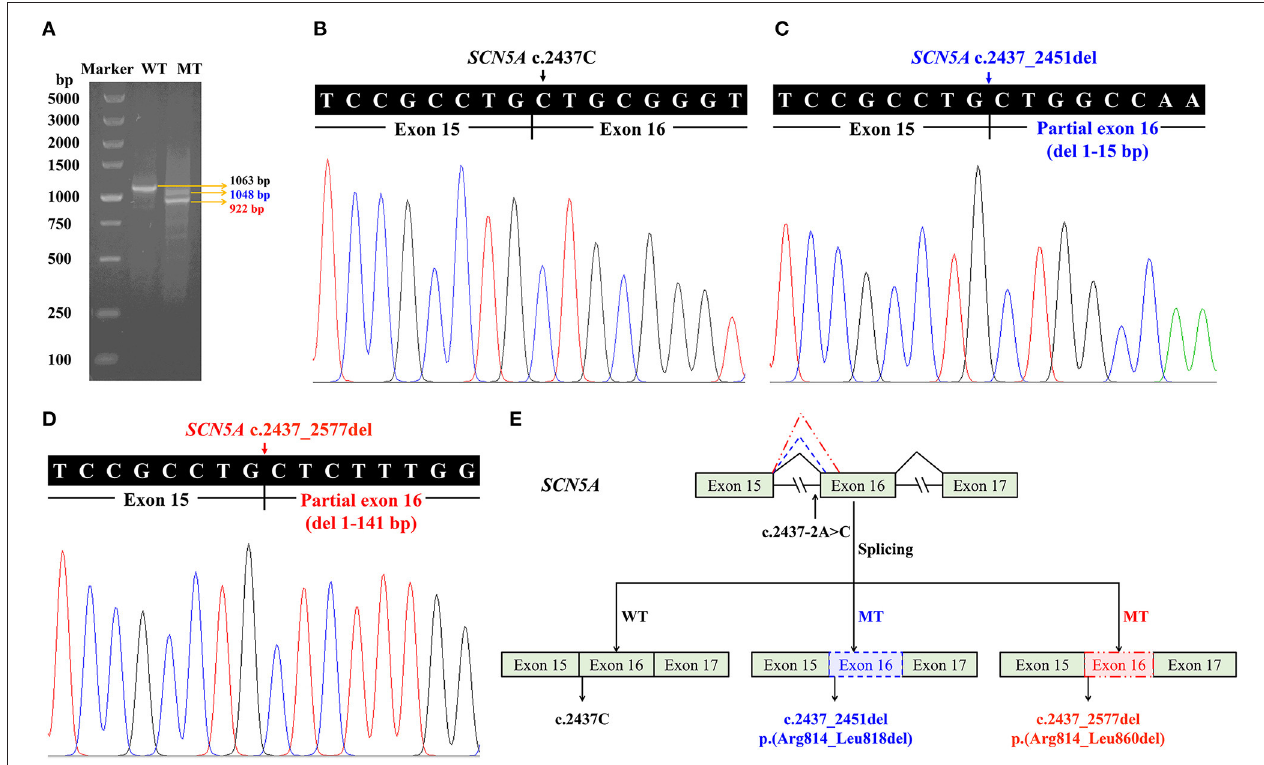
FIGURE 4 | Minigene assay for the sodium voltage-gated channel alpha subunit 5 gene ( SCN5A ) c.2437-2A > C variant and the schematic splicing model. (A) Electrophoresis of reverse transcription PCR products, with mRNA extracted from cells transfected with pMini-CopGFP- SCN5A (WT for wildtype: 1,063 bp, MT for mutant: 1,048/922 bp). (B) Sanger sequencing of the wildtype (1,063 bp) shows a junction between exons 15 and 16. (C) Sanger sequencing of the mutant (1,048 bp) indicates a deletion of 15 bp from exon 16. (D) Sanger sequencing of the mutant (922 bp) indicates a deletion of 141 bp from exon 16. (E) A schematic splicing mechanism of the SCN5A c.2437-2A > C variant. The continuous lines between exons show the normal splicing of the wildtype, and the dotted lines demonstrate the aberrant splicing, resulting in activation of two cryptic sites and partial loss of exon